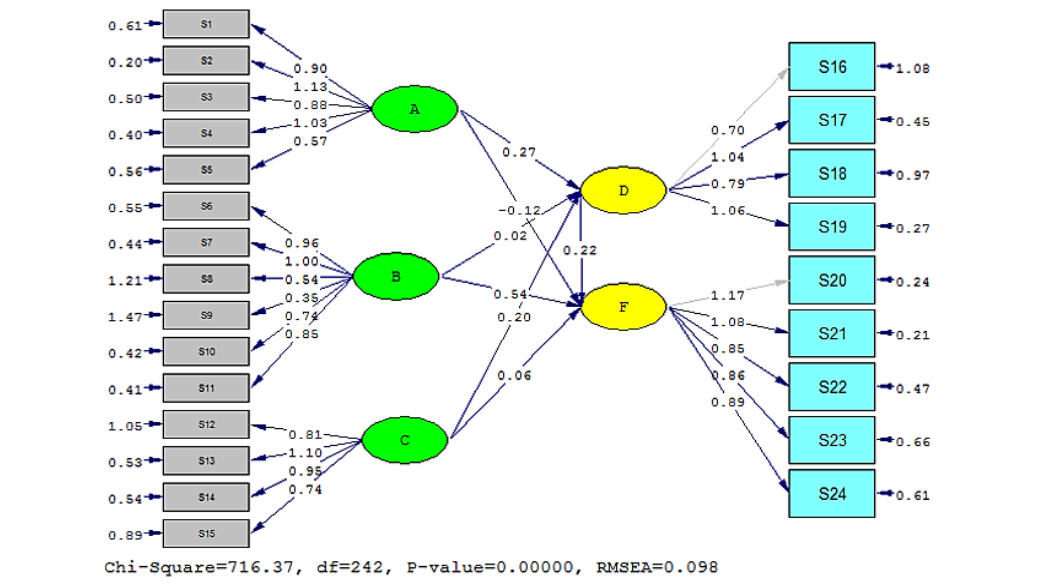
Fig. 2. Non-standardized coefficient model of structural